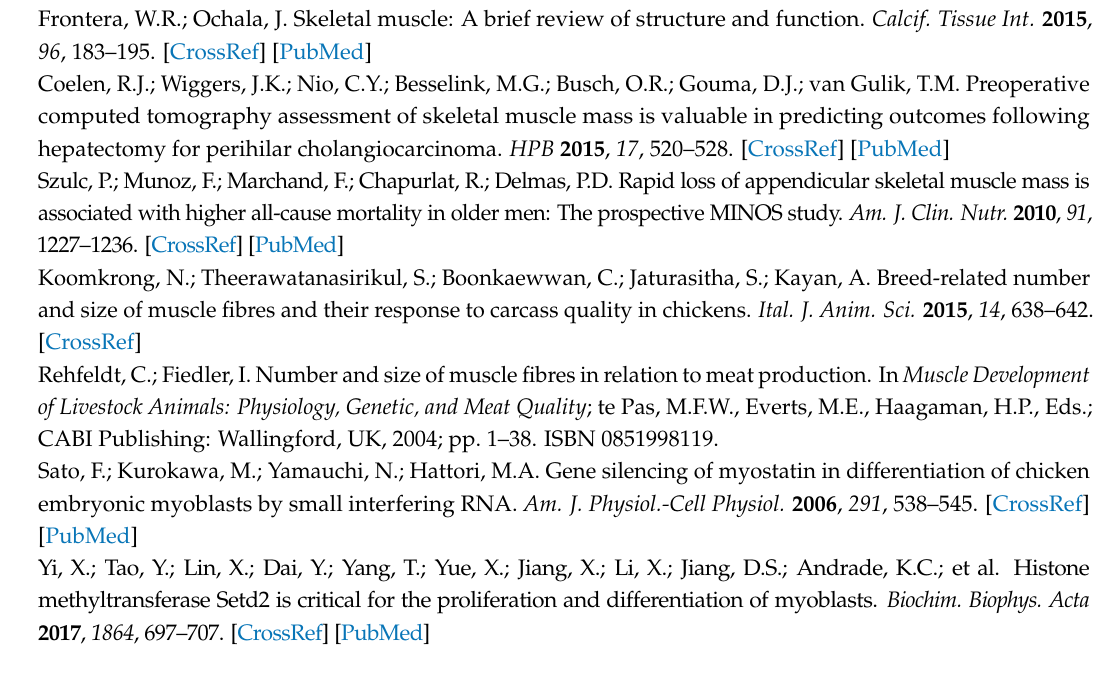
lncRNAs; Table S6. Functional enrichment analysis of protein-coding genes co-expressed with lncRNAs; Table S7. List of differentially-expressed lncRNAs and mRNAs from four myoblasts developmental stages; Table S8. Differentially-expressed genes for K -means analysis; Table S9. Functional enrichment analysis of DEGs involved in K1, K2, K3, and K4